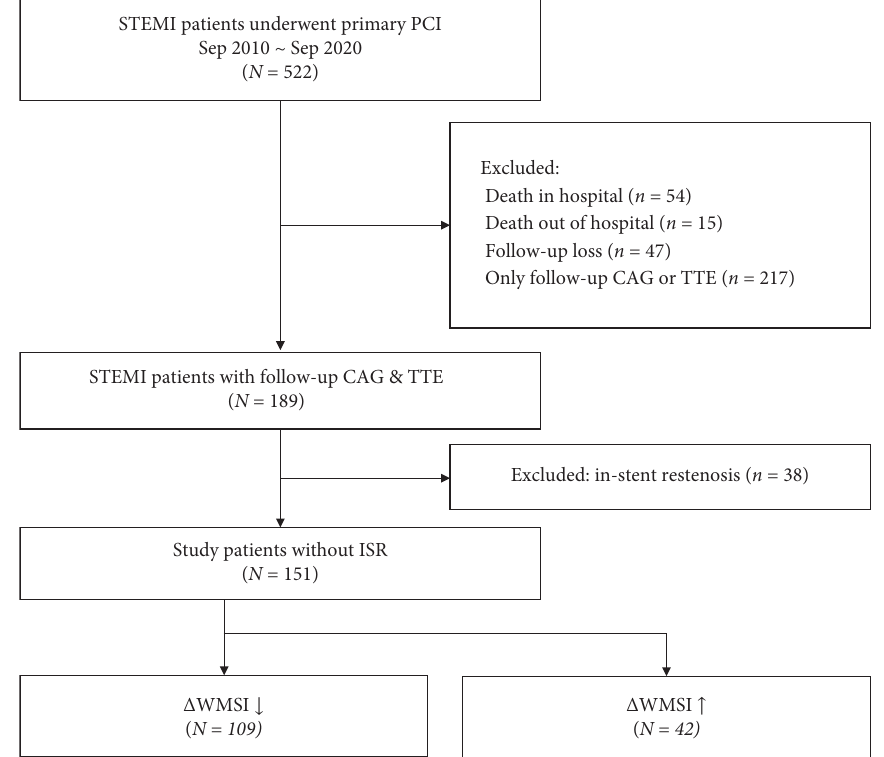
Figure 1: Patient flowchart. CAG � coronary angiography; ISR � in-stent restenosis; STEMI � ST-segment elevation myocardial infarction; TTE � transthoracic echocardiography; WMSI � wall motion score